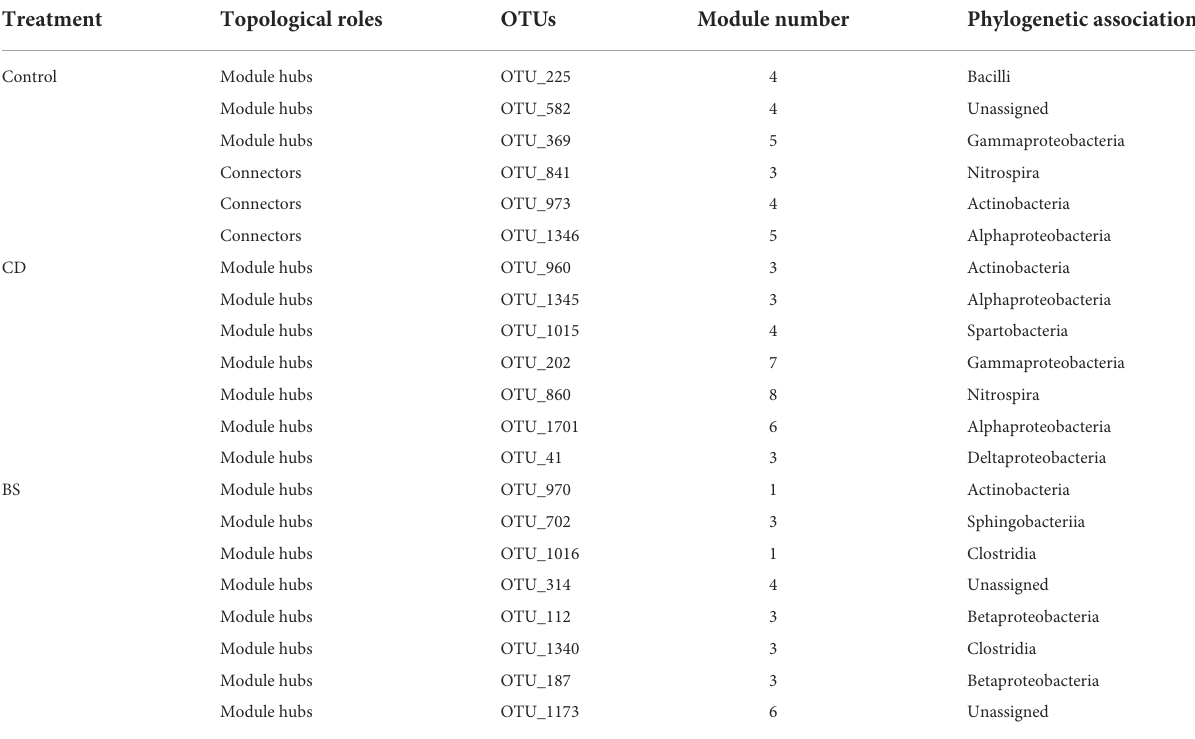
TABLE 3 Topological roles of intestinal microbiota in Pengze crucian carp.